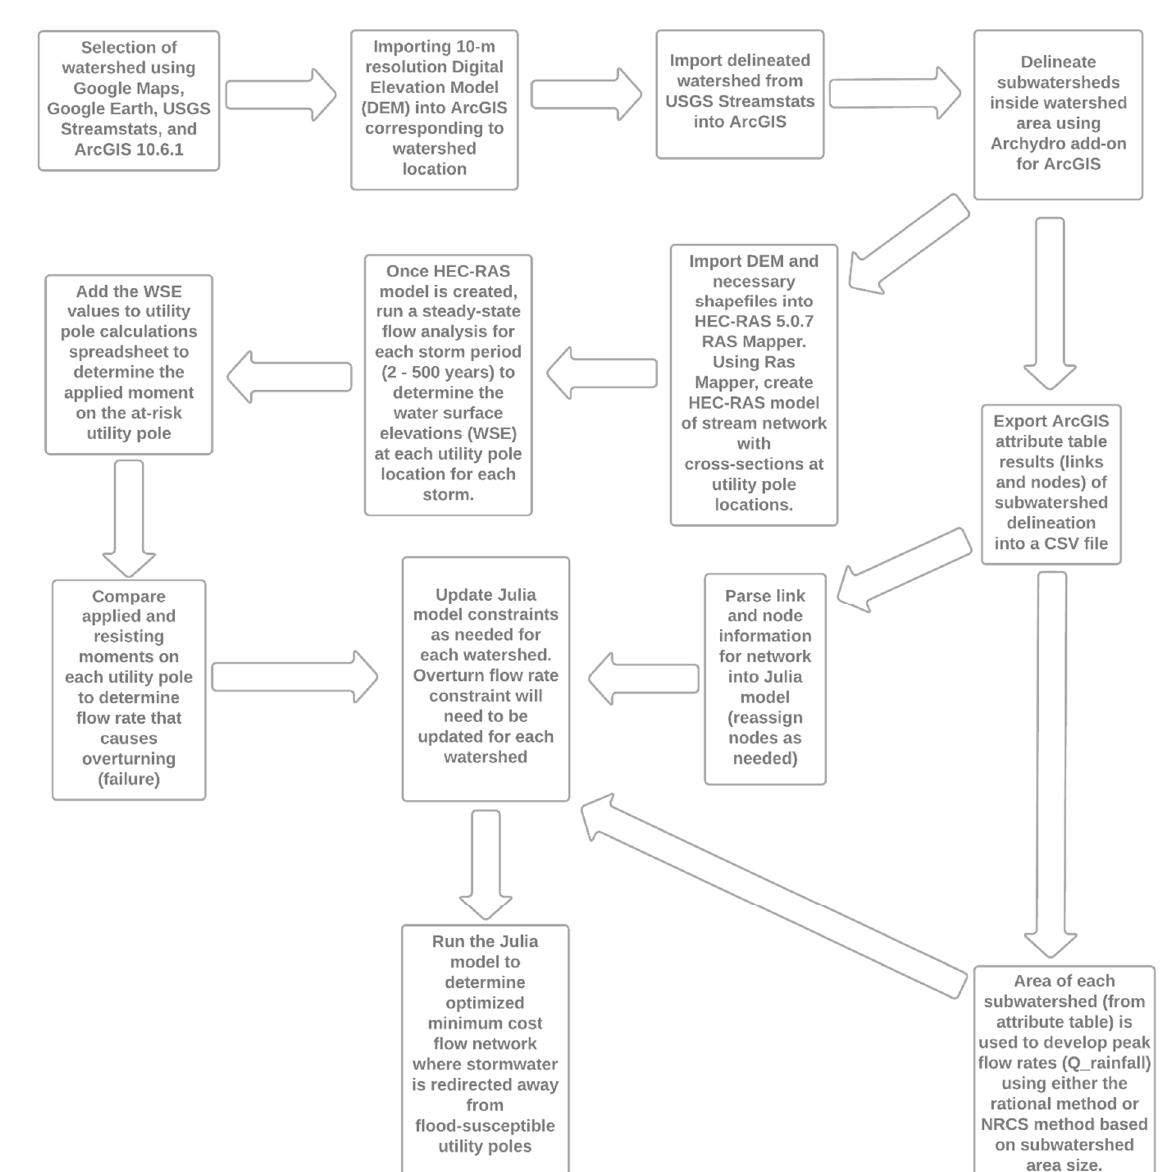
Figure 5. Methodology workflow to generate the decision support system to mitigate flood water impact on utility poles.